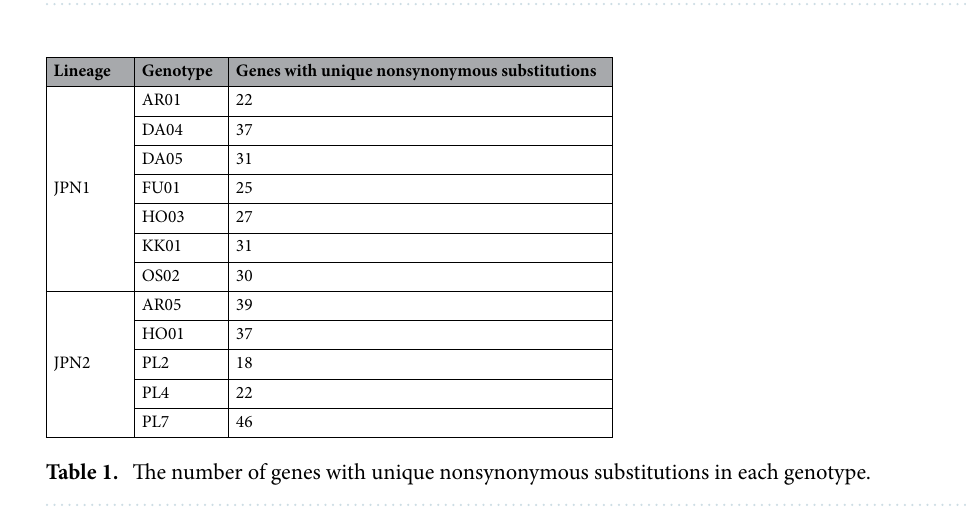
Figure 3 . Results of pairwise comparisons among genotypes within lineages for the number of substitutions in the coding and non-coding regions, showing the numbers of synonymous ( a ) and nonsynonymous substitutions plotted against that of substitutions in the non-coding region ( b ), the number of nonsynonymous substitutions plotted against that of synonymous substitutions ( c ), and the number of homozygous substitutions plotted against heterozygous substitutions in synonymous substitutions ( d ) and nonsynonymous substitutions of the coding region ( e ). Red and blue circles indicate JPN1 and JPN2 lineages, respectively. The slopes (mean ± 95%CI) of significant regression lines are shown in squares of each panel with the significant probability ( p ) of difference between the two slopes.